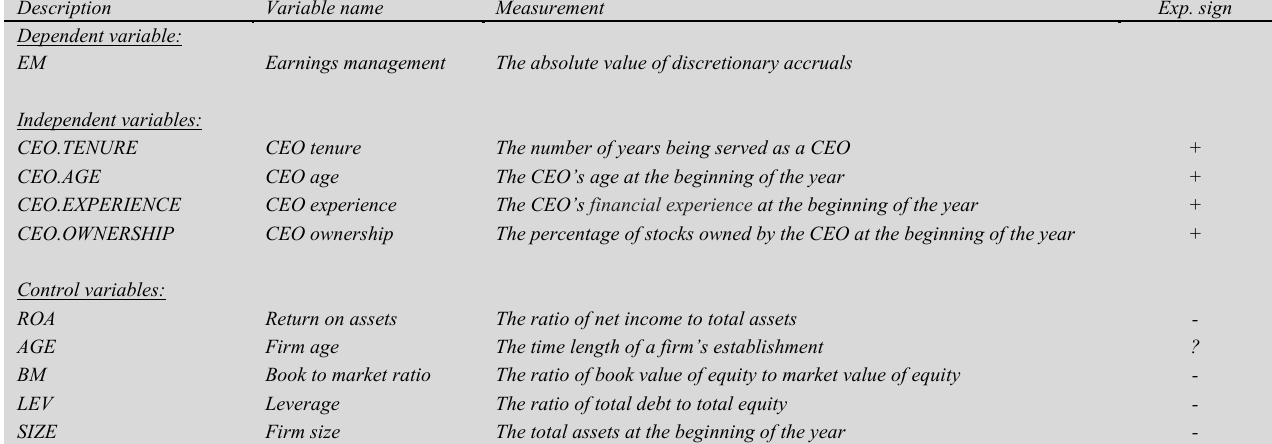
Summary of variables and their